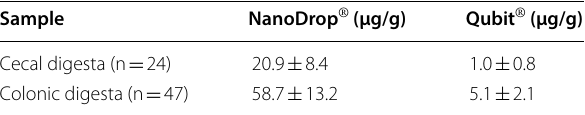
Table 1 Comparison of microbial DNA concentration from pig digesta samples measured by NanoDrop ® spectrophotomer and Qubit ® fluorometer quantitation